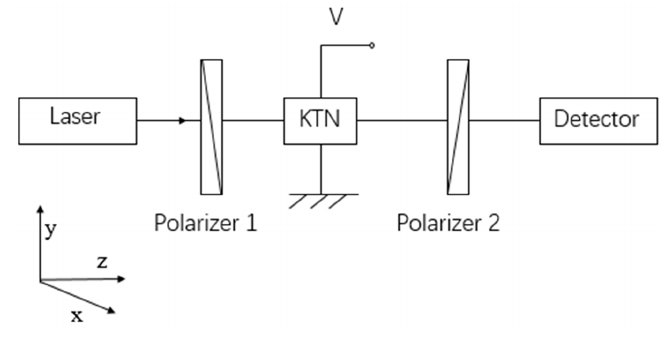
Figure 1. A diagram of experimental light path.